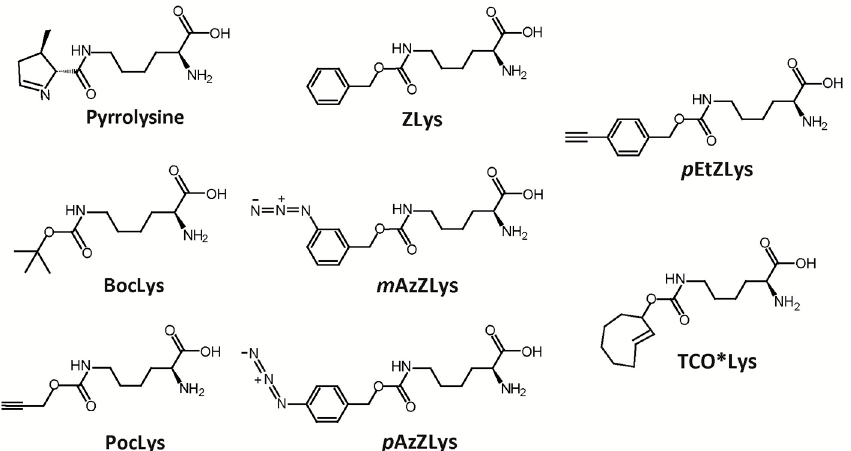
Scheme 1. Chemical structures of pyrrolysine (Pyl) and non-canonical amino acids: BocLys,